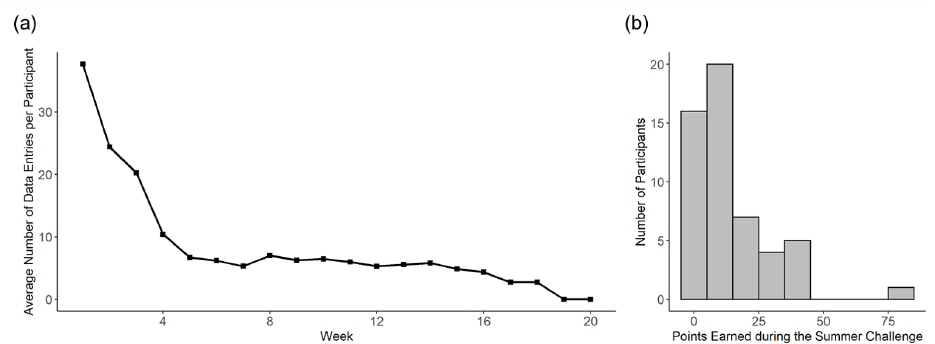
Figure 2. ( a ) User engagement over time as indicated by the average number of data entries per participant; ( b ) Histogram of points earned by participants during the summer